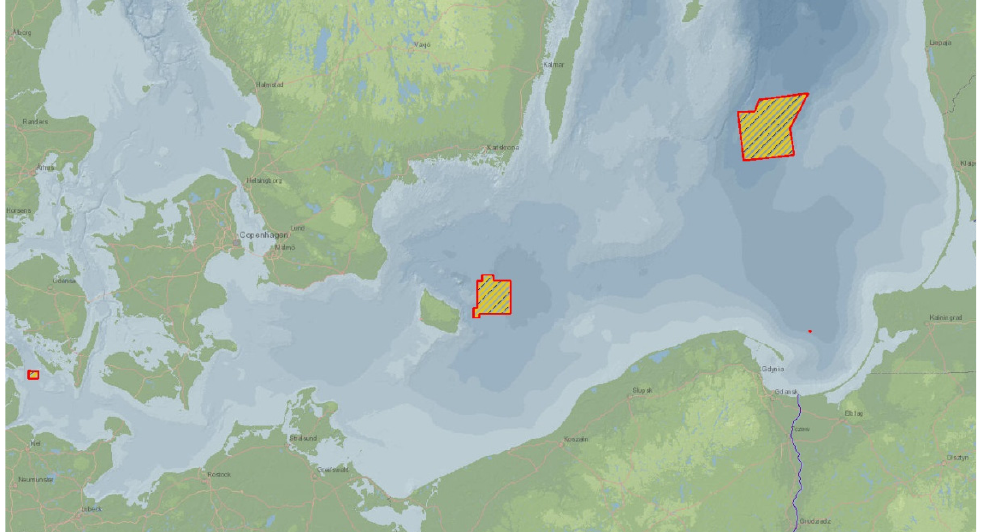
Figure 4. Main munition dumpsites in the Baltic Sea, based on HELCOM Map and Data Service [5].